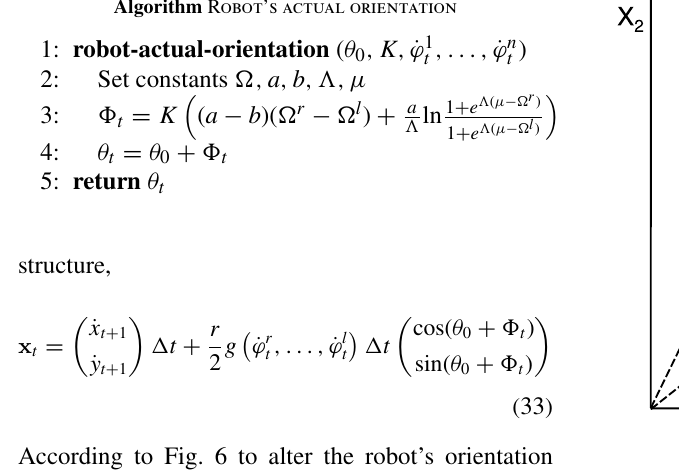
Fig. 6. Geometric definition of f (cid:8)